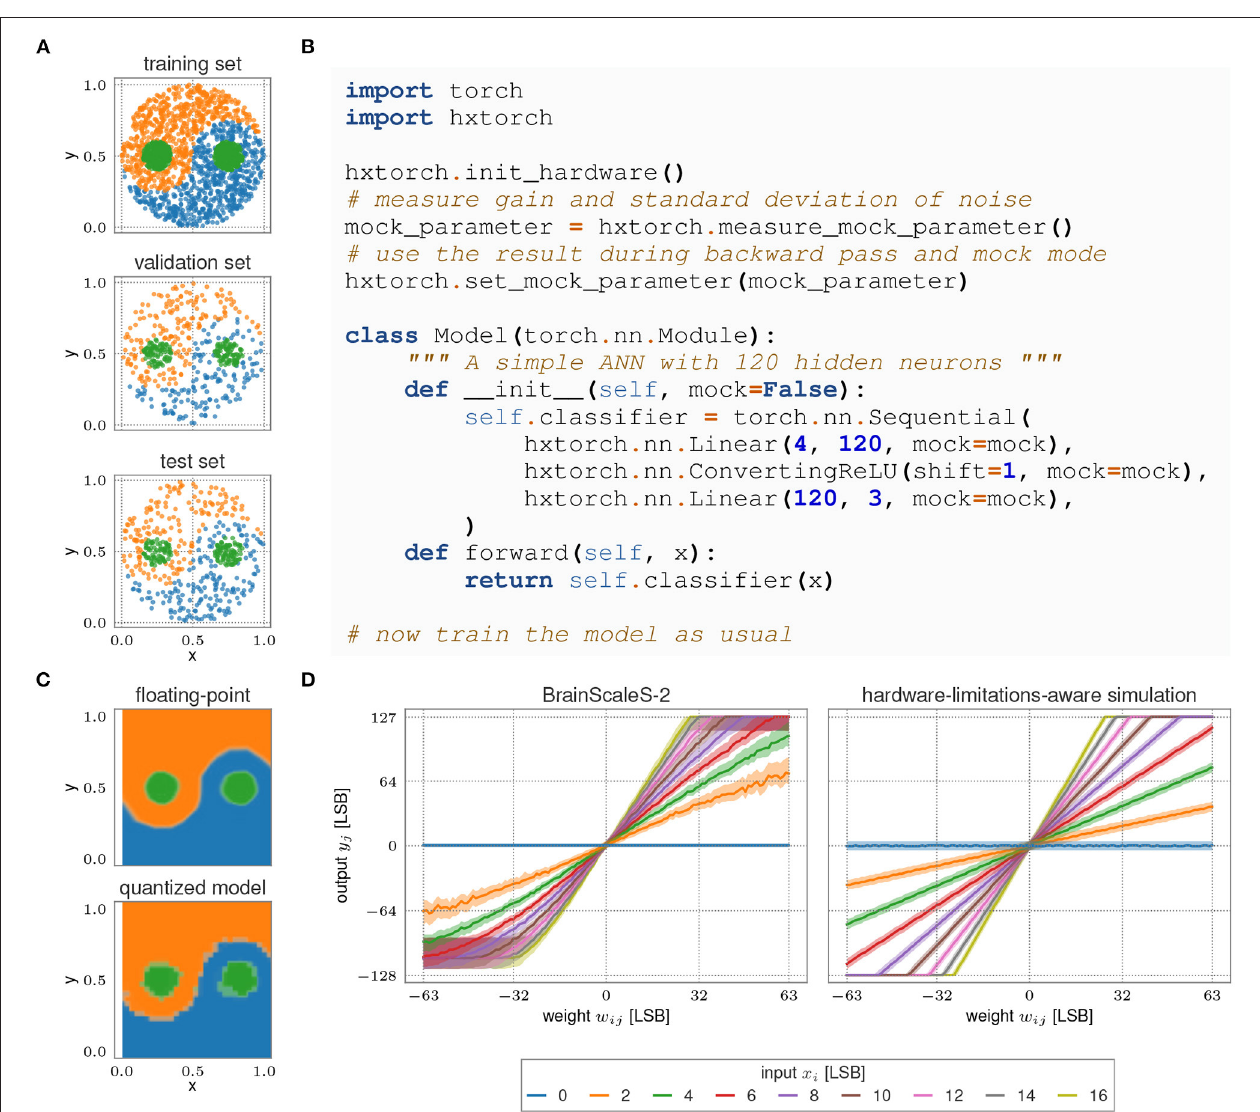
FIGURE 13 | (A) The Yin-Yang dataset (Kriener et al., 2021) used for the experiment. (B) Hardware initialization and model description with hxtorch . (C) Network response of the trained model depending on the input. (Top) 32bit floating-point precision; (Bottom) Quantized model on BSS-2 (5bit activations, 6bit plus sign weights). (D) Output of the MAC operation on BSS-2 (left) compared to the linear approximation (right). The solid line indicates the median, the colored bands contain 95% of each neuron’s outputs across 100 identical MAC